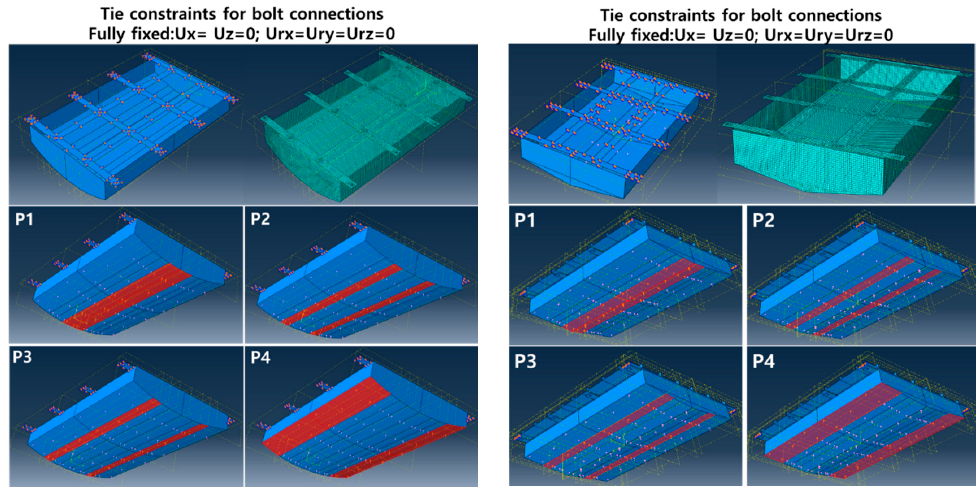
Figure 16. Finite element model of the cylindrical model (left) with deadrise angle of 10° (right).